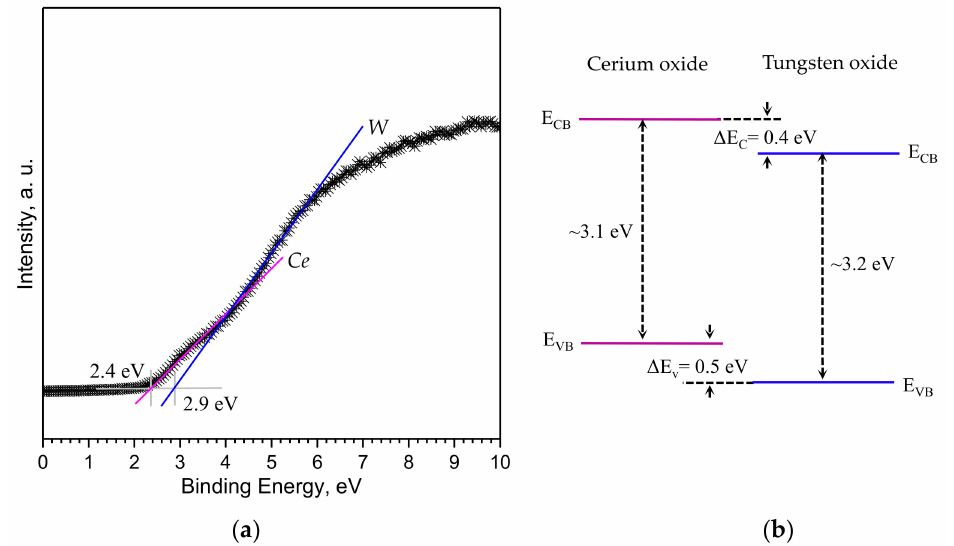
Figure 6. ( a ) The XPS valence band spectra of the cerium-modified tungsten oxide nanowires, and ( b ) schematic of the estimated energy level diagram at the interface. E CB and E VB represent the conduction band minimum and the valence band maximum (not to